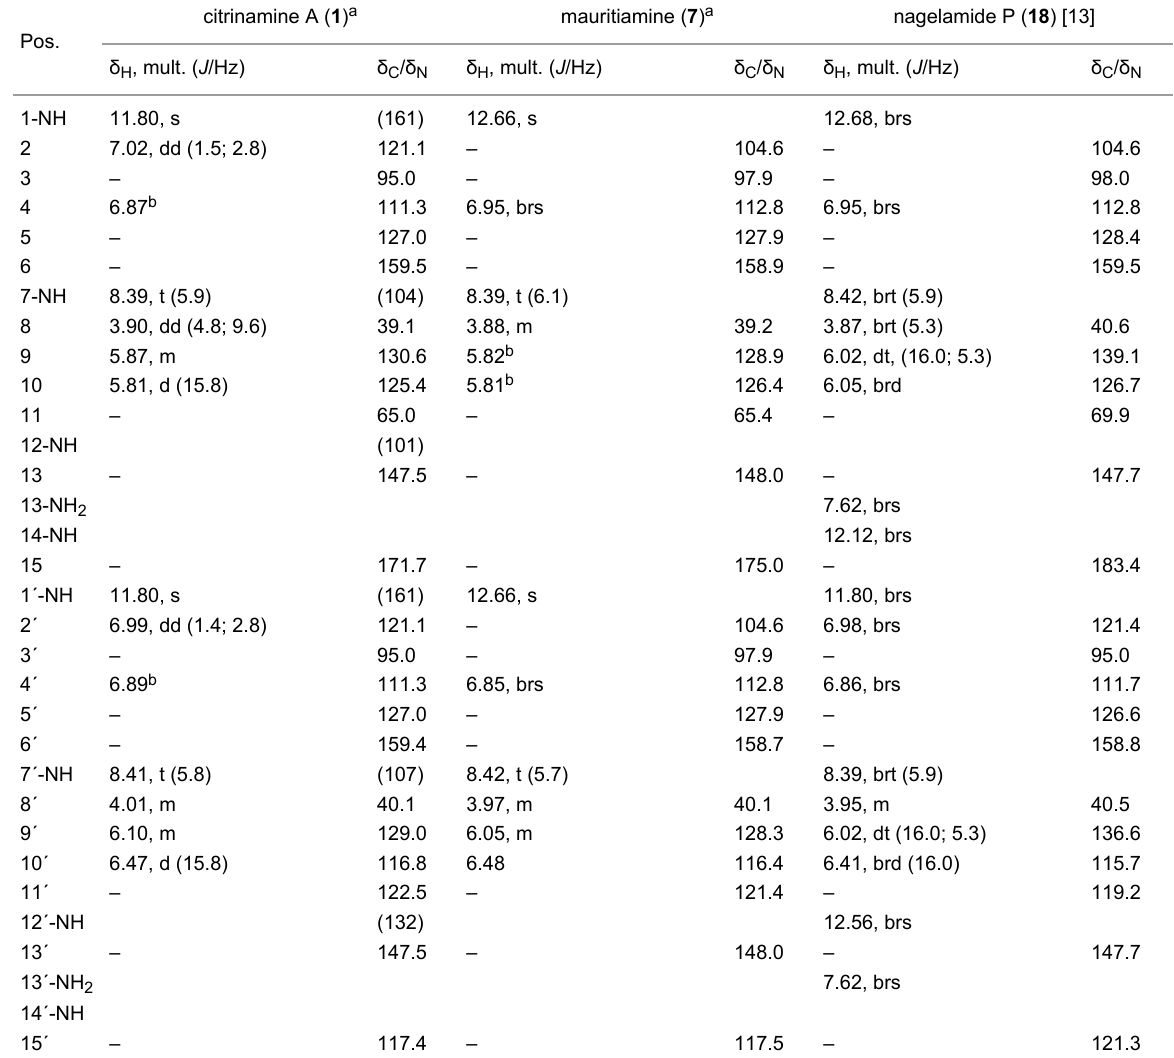
Table 1: 1 H, 13 C, and 15 N chemical shifts of citrinamine A ( 1 ) (600 and 850 MHz, DMSO- d 6 ) in comparison to mauritiamine ( 7 ) (600 MHz, DMSO- d 6 ) and nagelamide P ( 18 ) (500 MHz, DMSO- d 6 ).